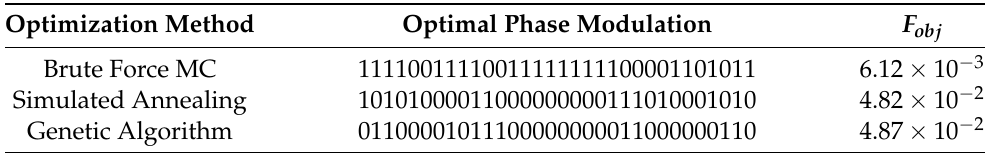
Table 4. Comparison of various phase-only optimization methods for the target intensity profile in Figure 6d.